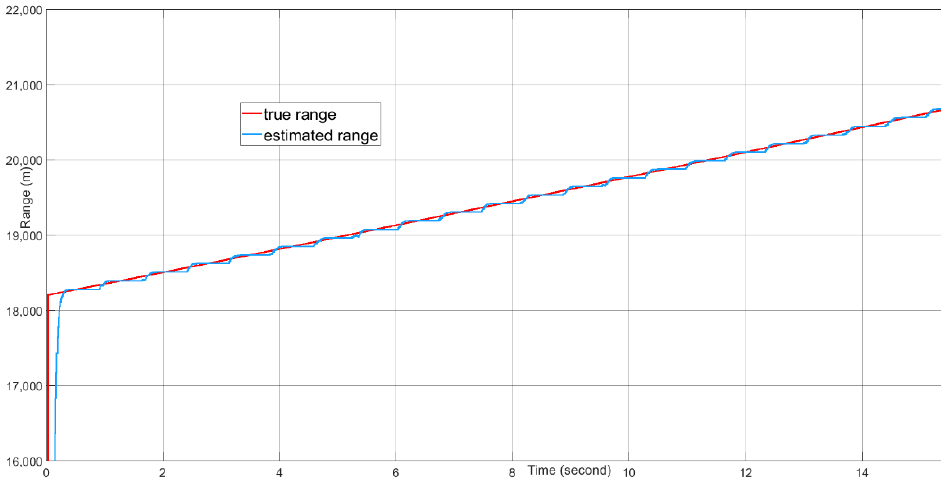
Figure 17. The range tracking performance over time.